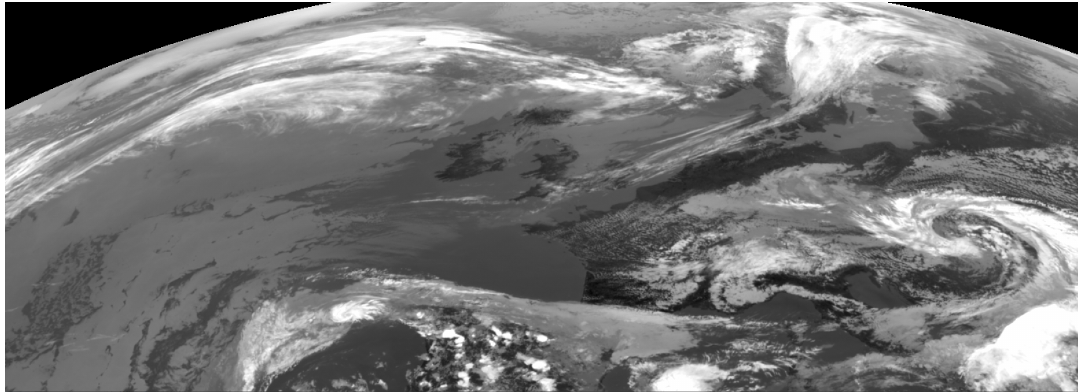
Figure 14. Brightness temperature image at 11 µ m. The scale ranges from 230 K (white) to 300 K (black).